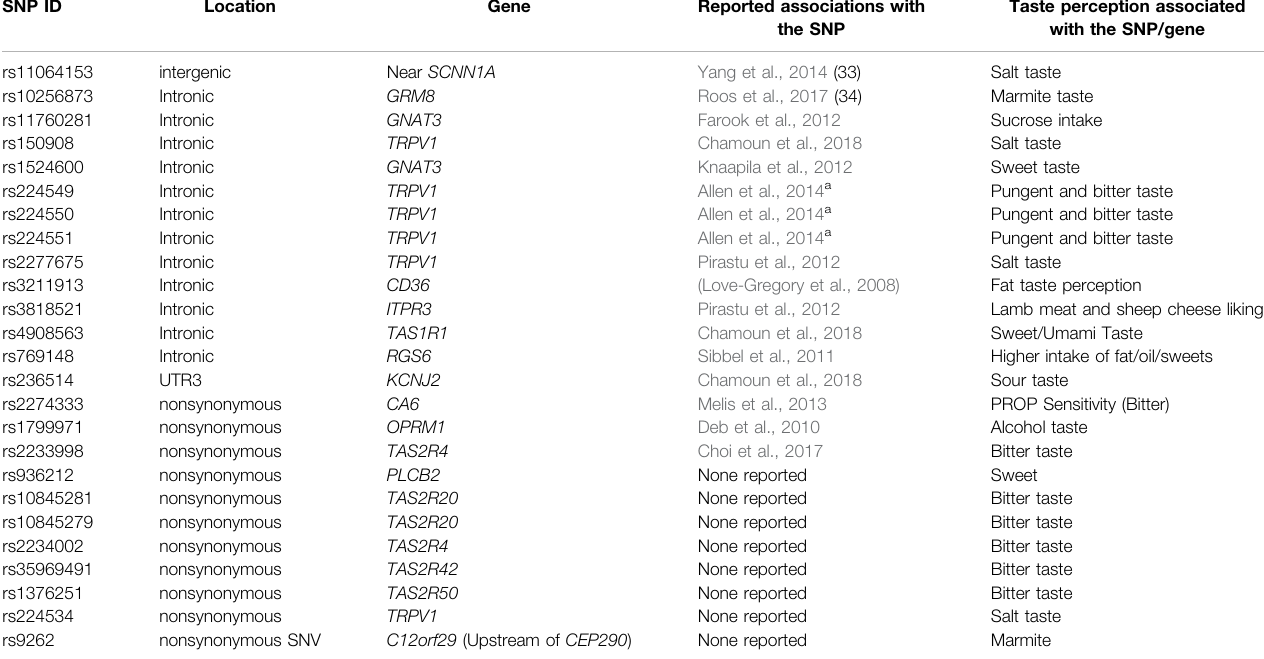
TABLE 1 | High F ST variants differentiating world populations either earlier reported to be associated with taste perception or nonsynonymous functional